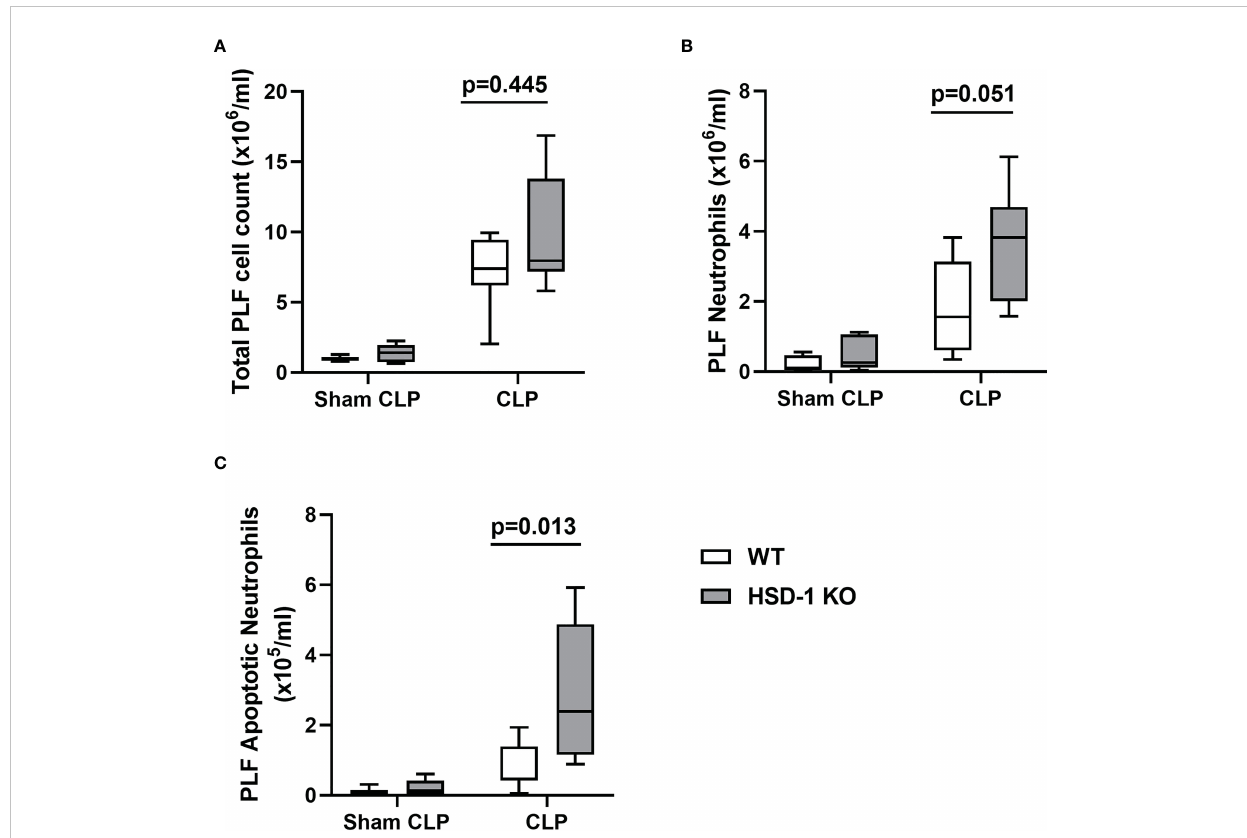
FIGURE 4 CLP injury in HSD-1 knockout mice is associated with accumulation of apoptotic neutrophils within the peritoneum. Time course of CLP injury and sham CLP was 16 hours, n ≥ 6 in each group (for both CLP and sham CLP). (A) PLF total cell count in HSD-1 KO and WT mice (CLP medians 4.06 v 5.61 x10 6 , p=0.445). (B) PLF neutrophil count in HSD-1 KO and WT mice (CLP medians 3.83 v 1.57 x10 6 /ml, p=0.051). (C) PLF apoptotic neutrophil count in HSD-1 KO and WT mice (CLP medians 2.40 v 0.472 x10 5 /ml, p=0.013). CLP, Caecal ligation and puncture; HSD-1, 11 b